Question: What type of chart is this?
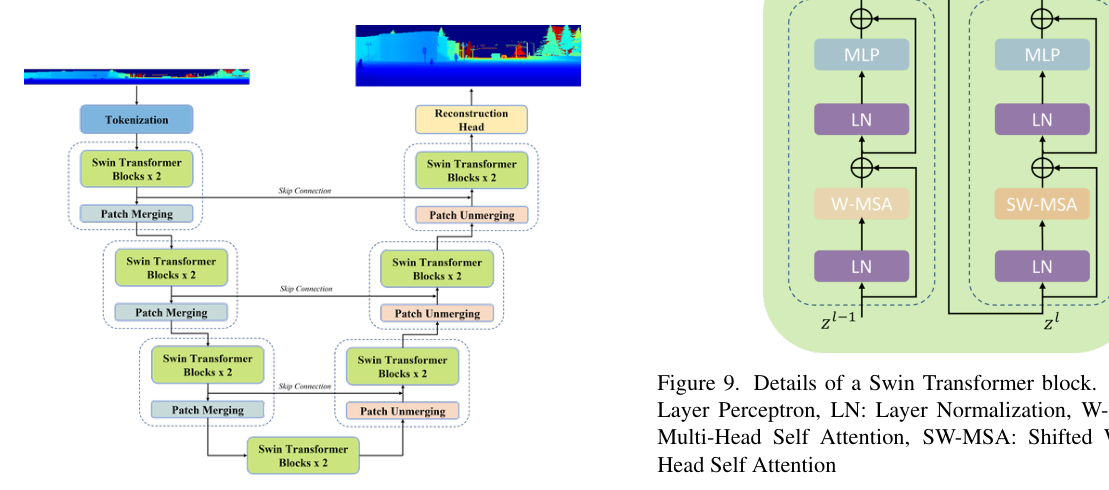
Answer: line